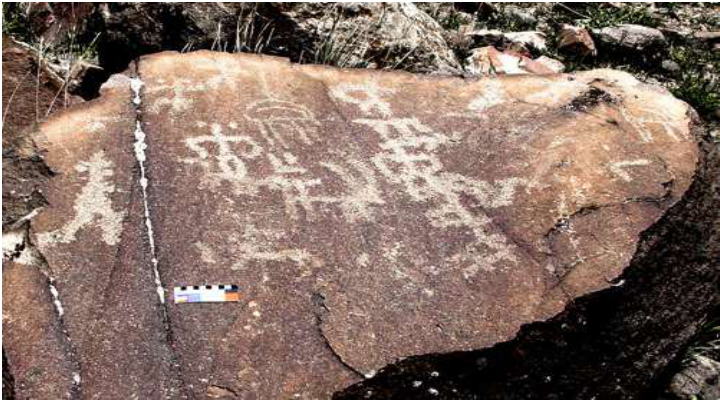
Figure 14. Qorwa, human-like images in different situations, dots and animals.